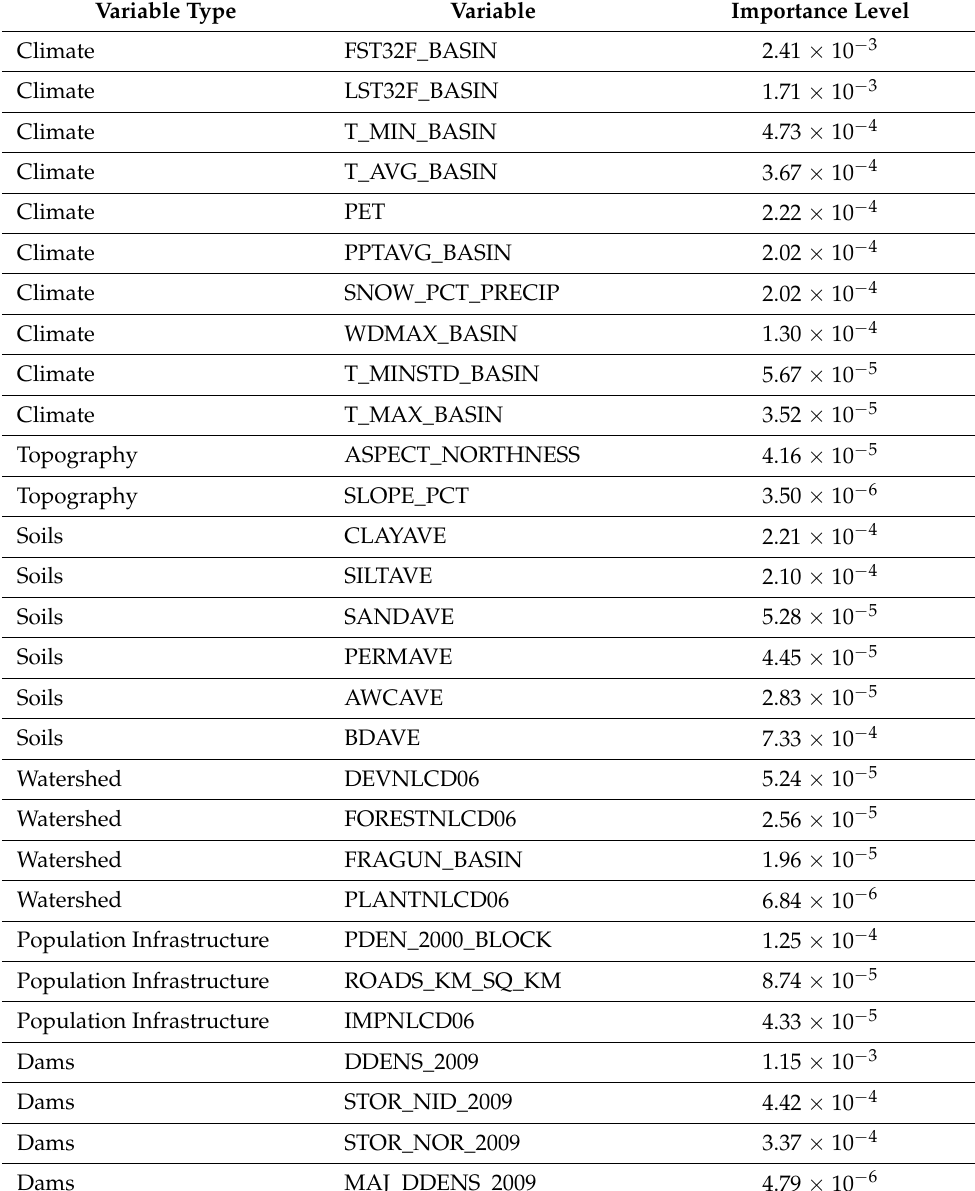
Table A4. Predictor variables retrieved for Interior